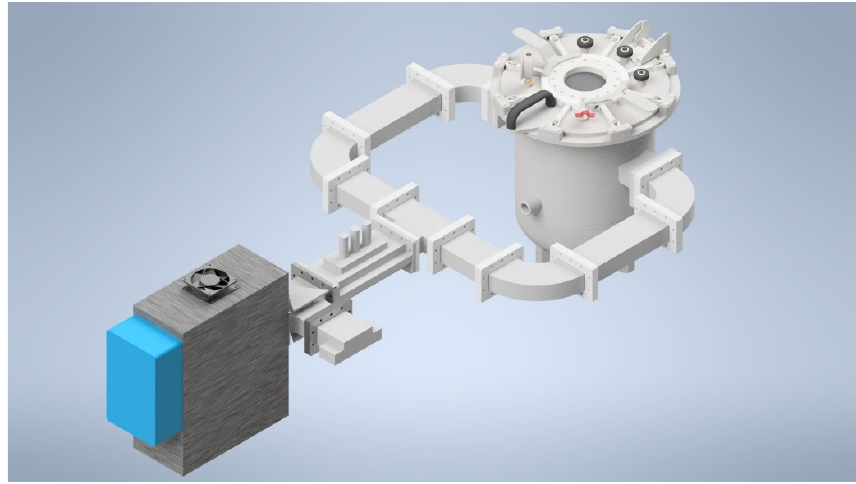
Figure 3. Experimental 30-liter microwave chamber, connected to a variable power 3-kW microwave generator.